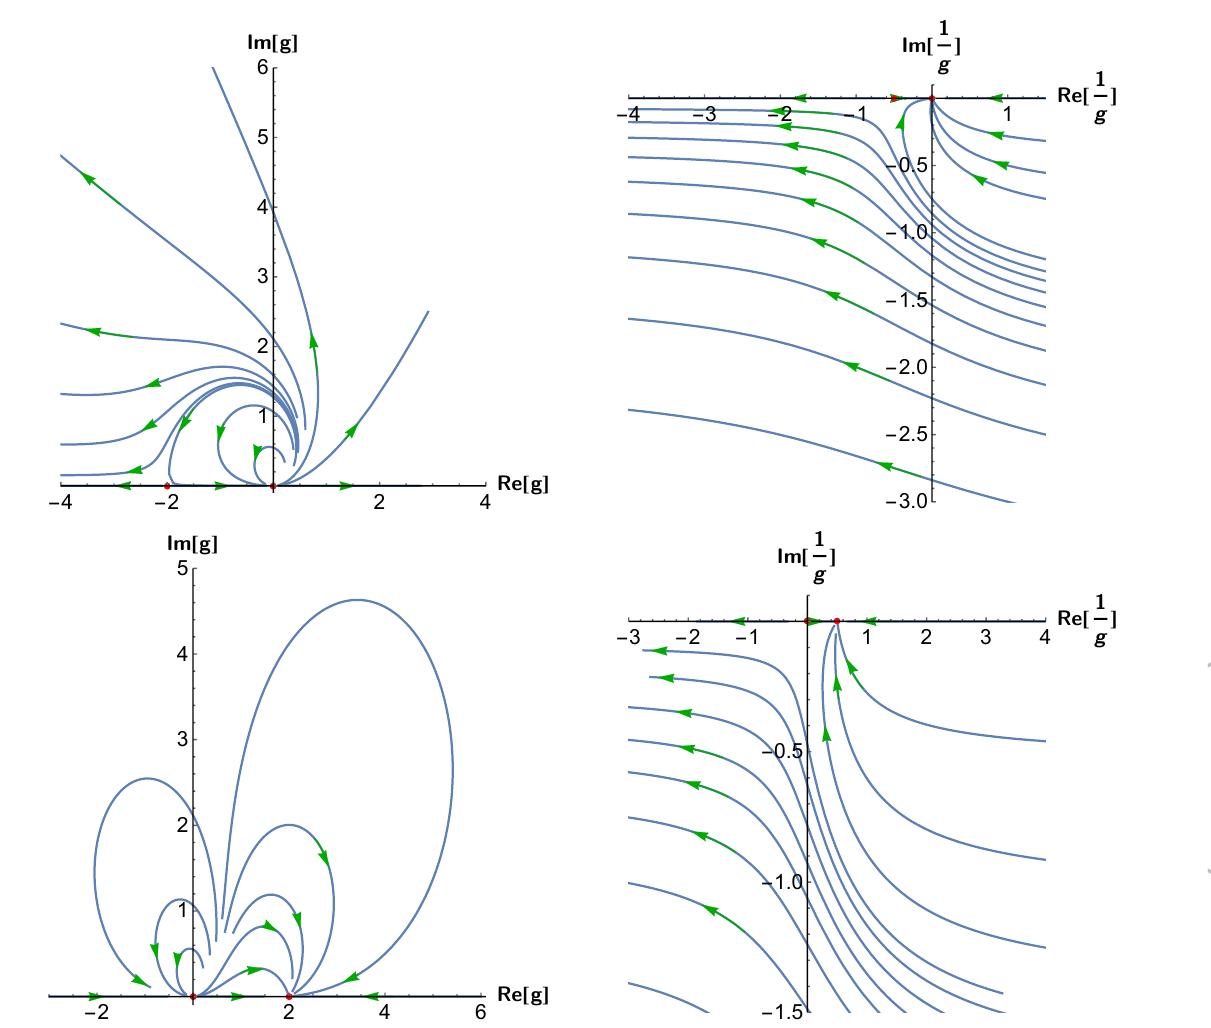
Figure 3 . The RG flow pattern over the complex g plane and the complex 1 /g plane. The top two and he bottom two are plotted using the beta function (4.8) and (4.13) respectively. Note that the lower left figure is the same as figure 1 in